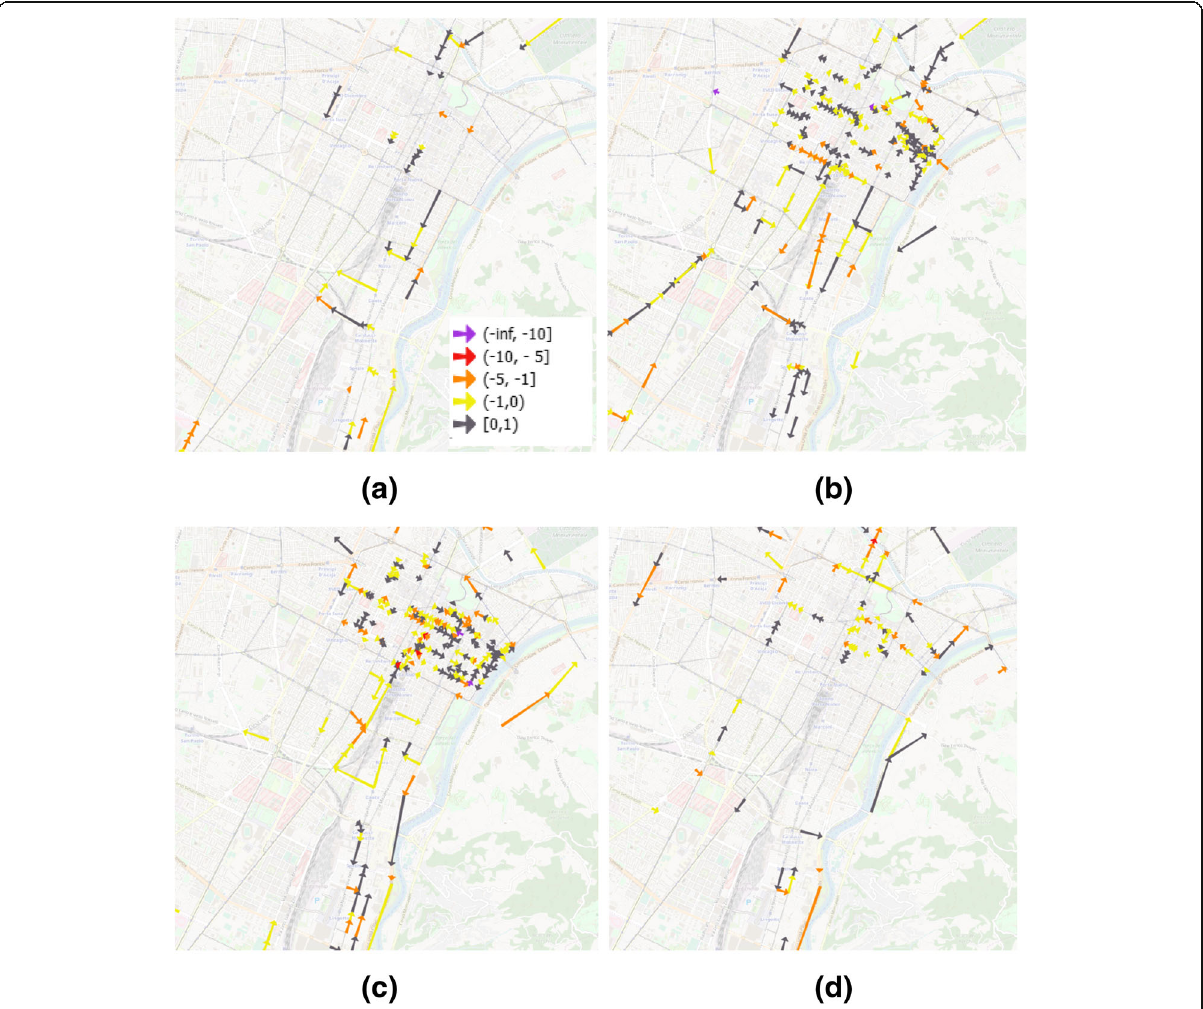
Fig. 2 Values of the worst RKPI j,k for the arcs of the city newtork in the time ranges 8:00 – 8:59 am ( a ), 9:00 – 9:59 am ( b ), 5:00 – 5:59 pm ( c ), 6:00 – 6:59 pm ( d ). Different colours of the arrows represent different values of the indicator according to the scale in figure ( a